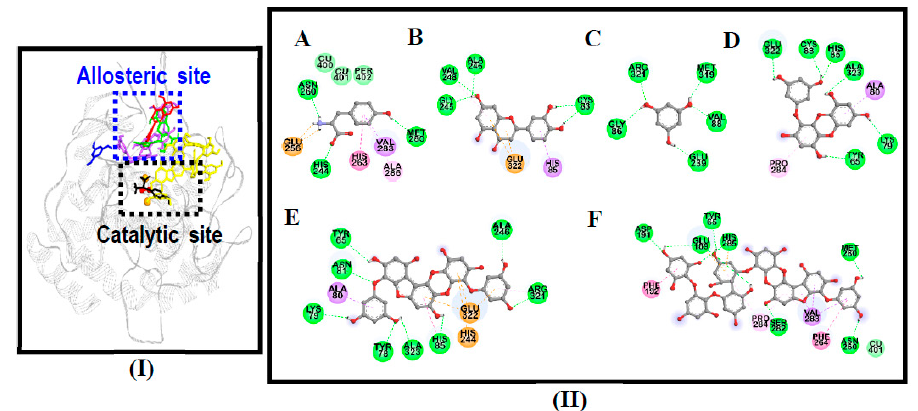
Figure 2. ( I ) Top binding mode of phlorotannins phloroglucinol (blue stick), eckol (green stick), phlorofucofuroeckol-A (purple stick), and 974-A (yellow stick) for the oxy-form tyrosinase with positive controls, l -tyrosine (black stick) and luteolin (red stick) ( A ). Copper and peroxide ions are shown in orange and red spheres, respectively. ( II ) 2D diagram showing l -tyrosine ( A ), luteolin ( B ), phloroglucinol ( C ), eckol ( D ), phlorofucofuroeckol-A ( E ), and 974-A ( F ) binding pose in active site of